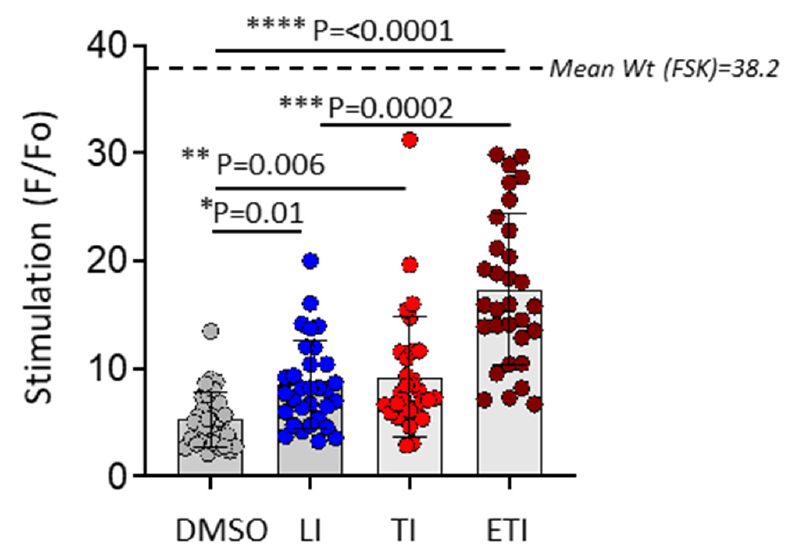
Figure 2. Summary of modulator responses measured in the plate reader assay (Figure 1) for 31 individuals, homozygous for F508del. Each dot represents data from cultures generated from a different individual. These cultures were treated for 48 h with the vehicle control (DMSO) and then acutely stimulated with forskolin. The cultures were also treated with correctors—lumacaftor (L, blue), tezacaftor (T, light red), or elexacaftor plus tezacaftor (ET, dark red) for 48 h. The mean forskolin response measured in non-CF cultures ( n = 9) is shown as a stippled line for comparison. Treatment with correctors (L, T, and ET) statistically enhanced FMP responses to forskolin plus ivacaftor, as determined by one-way ANOVA with multiple comparisons test.